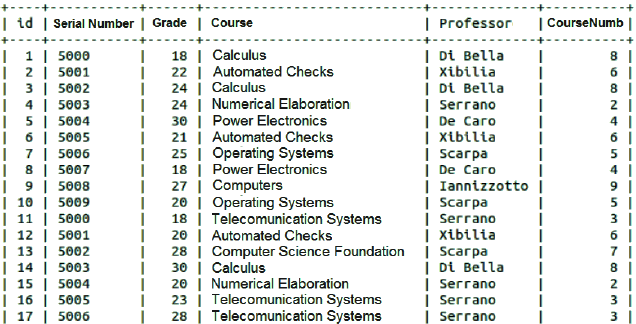
Figure 9. Result of the Inner Join operation performed on MySQL considering “Exam” and “Class” relations filtered by the “CourseNumb” field.